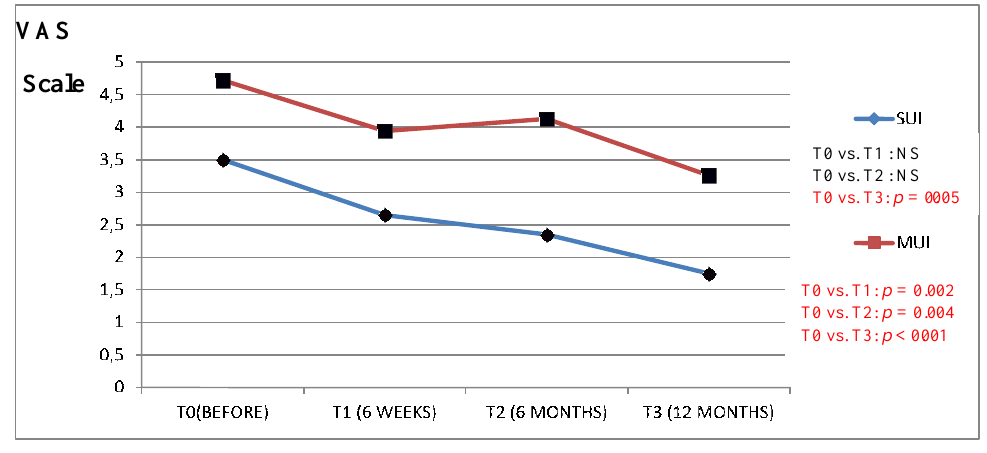
Figure 1. Impact of the vaginal native tissue repair (VNTR) on the pelvic pain associated with pelvic organ prolapse—according to the visual analogue scale (VAS).